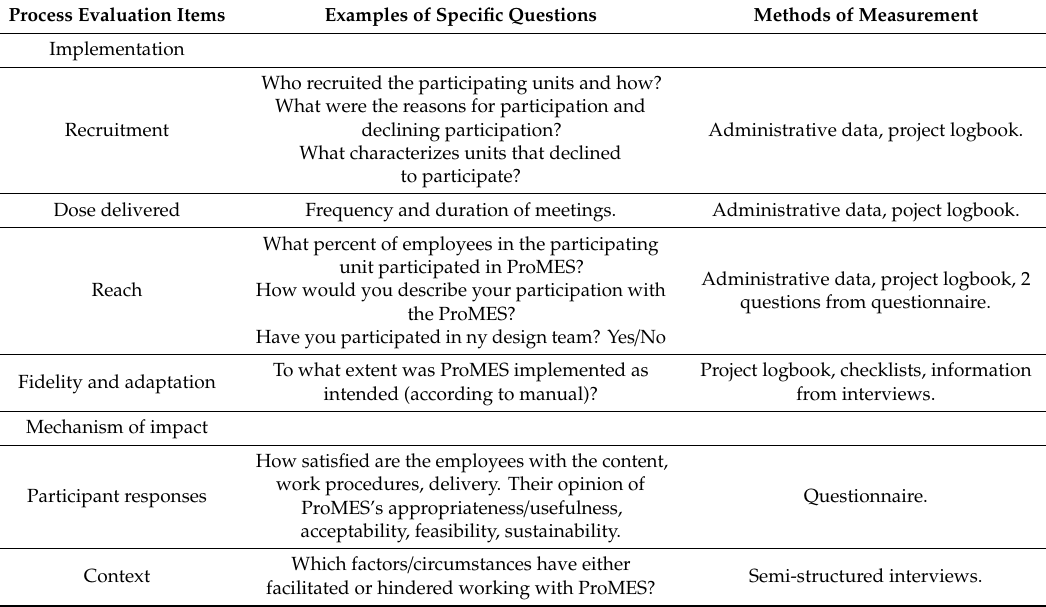
Table 2. Process evaluation items, examples of questions and methods of